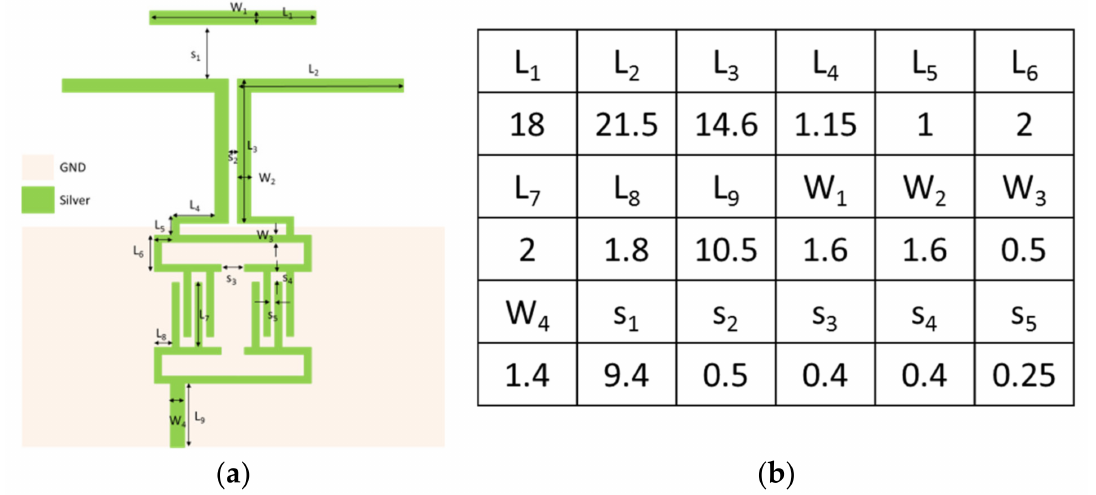
Figure 12. ( a ) Geometrical configuration of the proposed wound-dressing-based quasi-Yagi antenna. ( b ) Parameters of the designed antenna